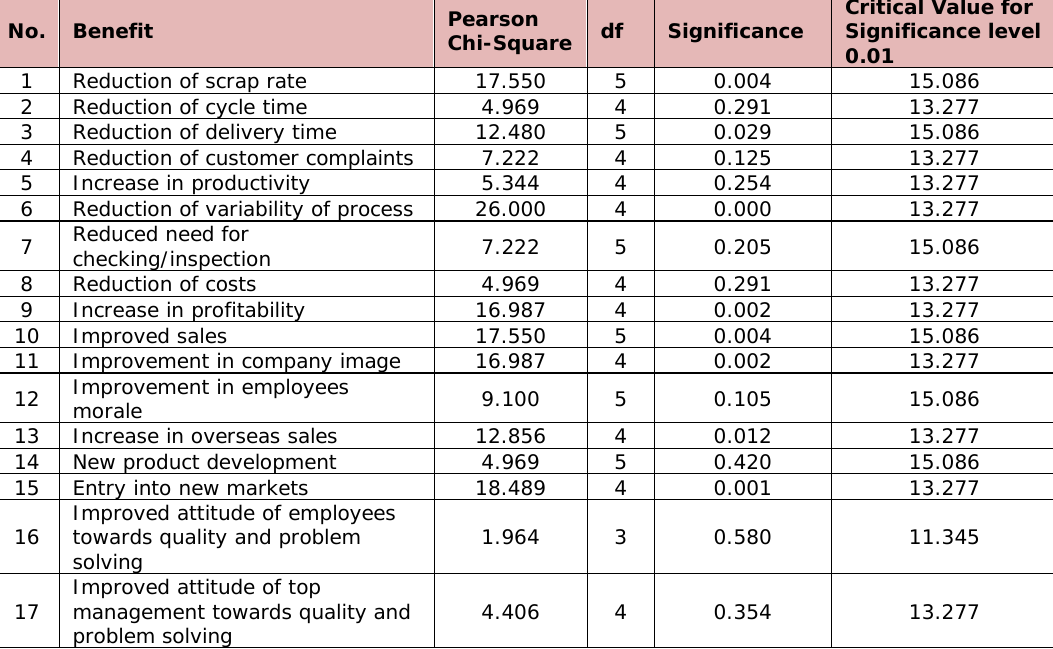
Table 4. “Pearson Chi-Square Values (Six Sigma benefits achieved by large and medium scale